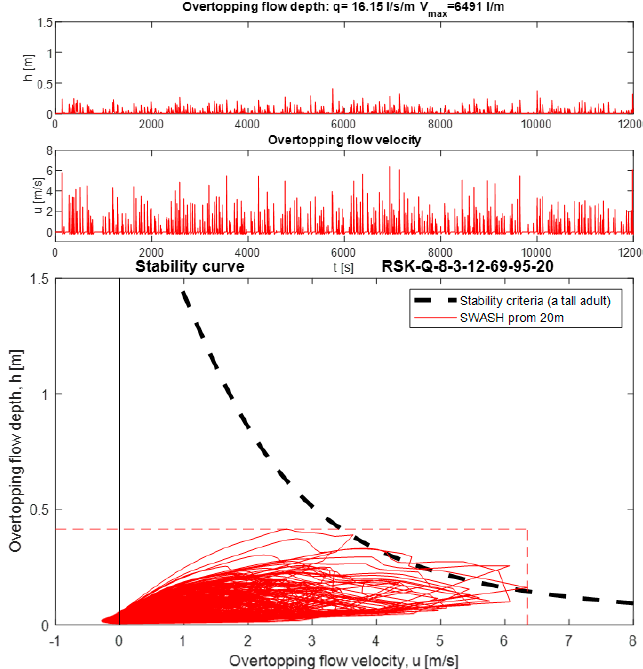
Figure 7. Time series of h and u (the first and second figures) and h-u relationship calculated in SWASH versus stability curve of a tall adult (the third figure): RSK_Q_8_3_12_69_95_20 00 (a case in which V is around 6500 l/s/m, and the promenade width of 0 m).